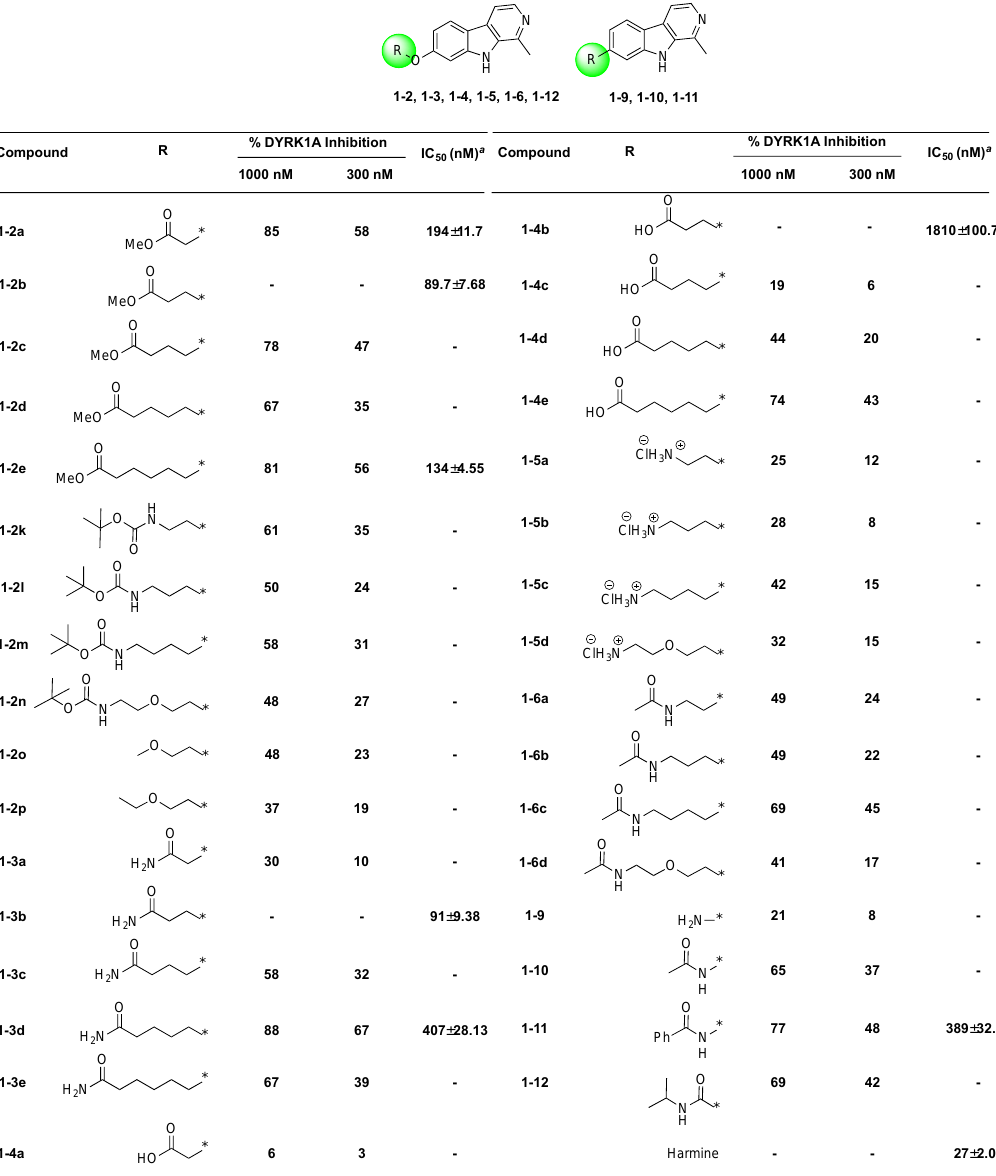
Figure 2. Dual-specificity Tyrosine-phosphorylation-Regulated Kinase A (DYRK1A) inhibition of 7- C harmine analogs a .